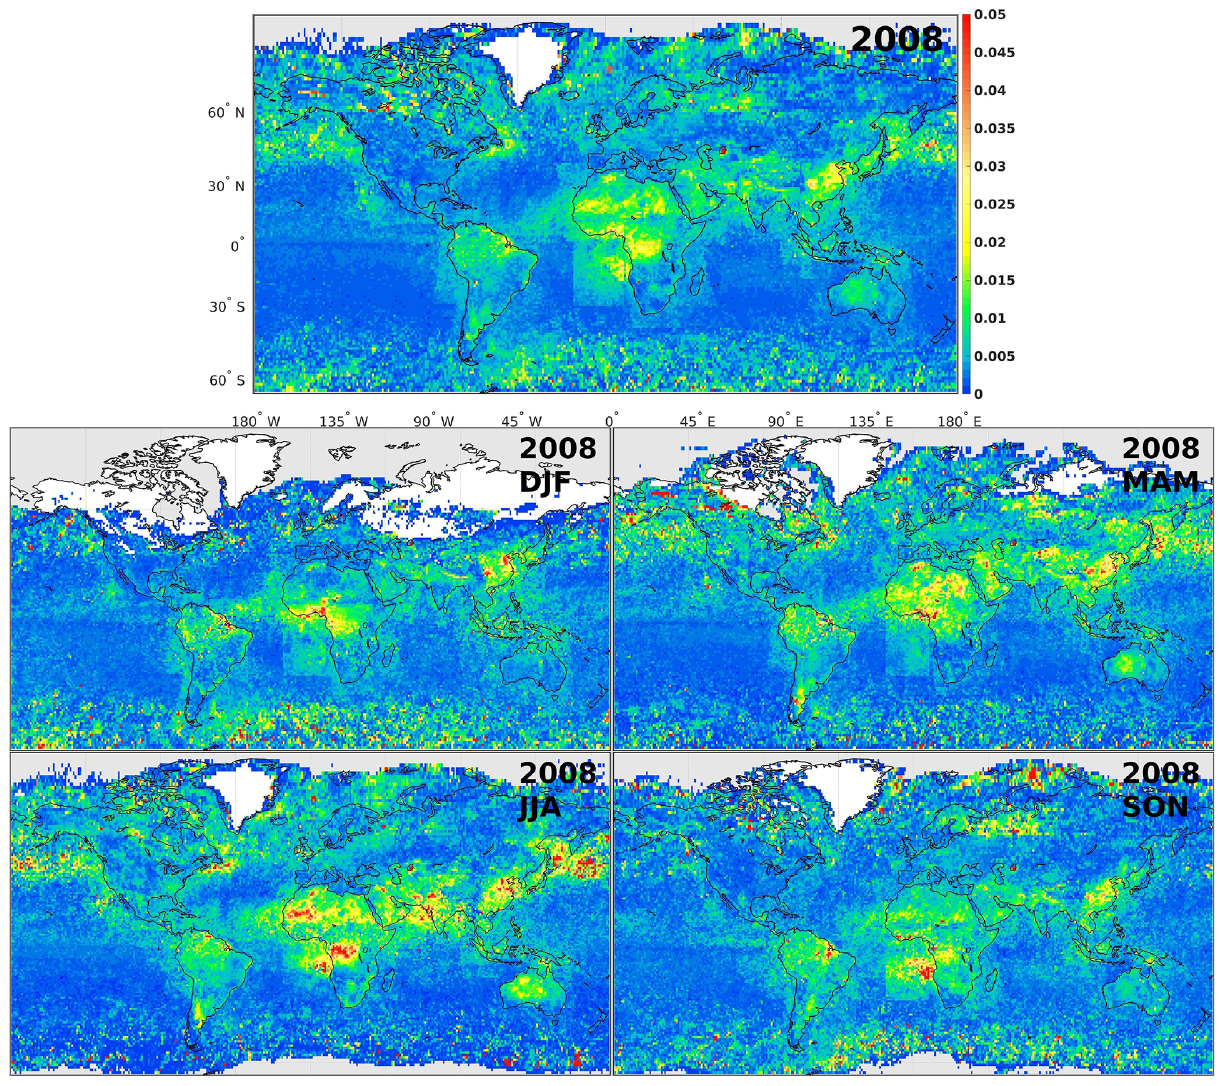
Figure 10. Seasonal and annual structural uncertainties between the L3 merged product (M; approach 2 with RM2 for all) and other L3 merged products calculated with the approaches 1 and 2 for the year 2008. Table 3. Mean offset and standard deviation (in parentheses) between time series obtained with different approaches for three time periods, determined based on products